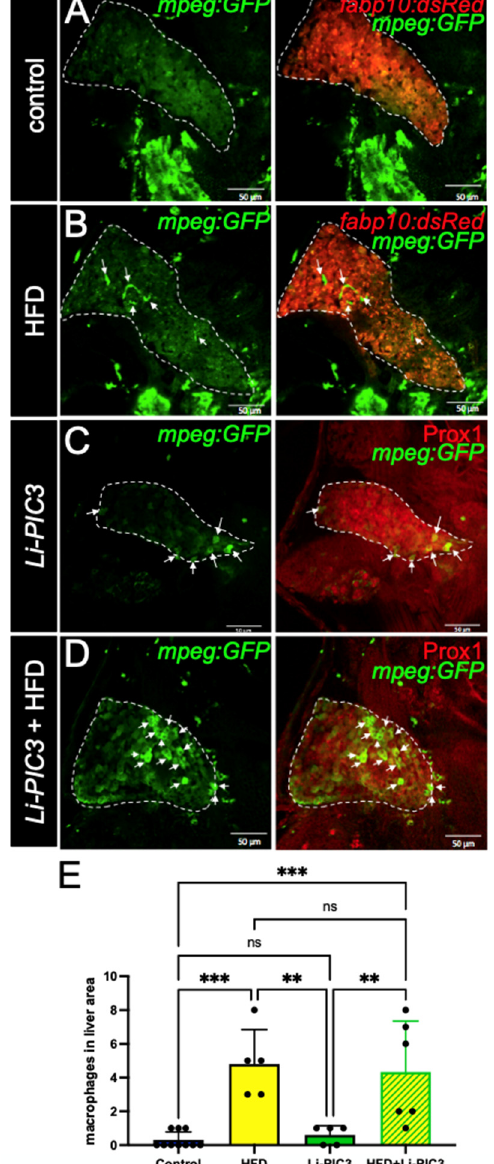
Figure 3. Macrophage infiltration is increased in HFD, Li-PIC3, and Li-PIC3+HFD larvae. ( A – D ) 7 dpf larvae labeled with GFP immunostaining to reveal macrophages and either a 2CLIP transgene ( A,B ) or immunolabeled with Prox1 antibody ( C,D ) to reveal hepatocytes. Infiltrating macrophages are indicated by white arrows. ( E ) Quantification of macrophages within the liver boundary reveals a statistically significant increase with HFD and Li-PIC3+HFD treatments. Statistical analysis by one-way ANOVA, ns-non significant, ** p < 0.01, *** p <